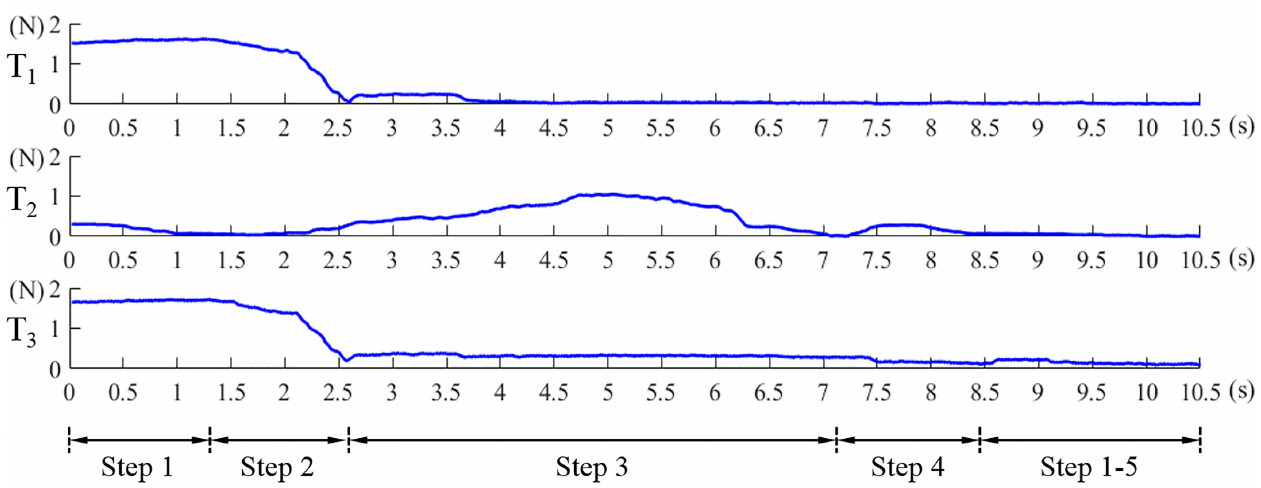
Figure 10. Values of T 1 , T 2 and T 3 in Equations (7)–(9). The abscissa axis of each curve indicates time and the ordinate axis indicates